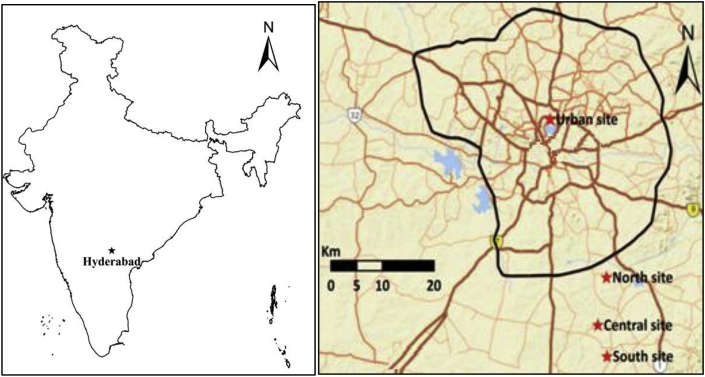
Monitor locations.